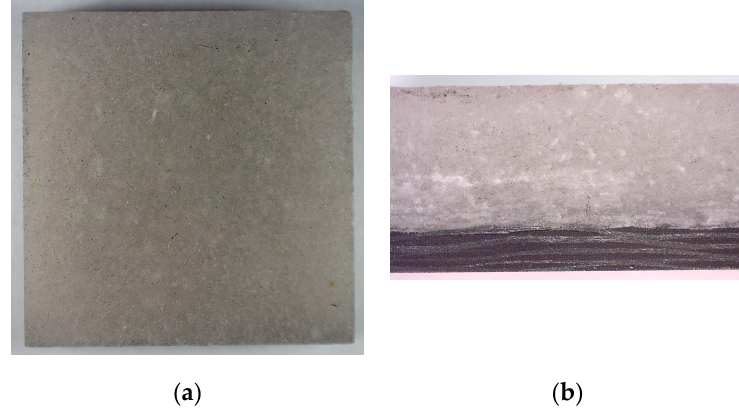
Figure 7. Internal structure of the TBC / PMC sample after impact with the pressure of 1 bar: ( a ) the TBC ceramic mat; ( b ) cross-section of the sample.